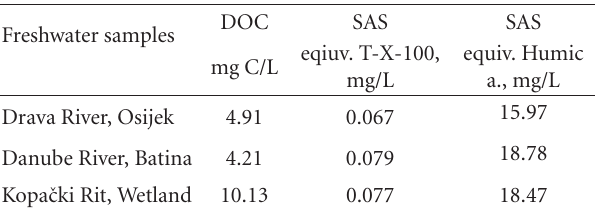
Table 1: Determination of surface-active substances in freshwater samples by electrochemical method. Concentrations are expressed in equivalent amounts of two di ff erent standards (Triton-X-100 and humic acid). Concentrations of dissolved organic carbon (DOC) in the samples are given too. Samples were collected and analyzed on March 3,